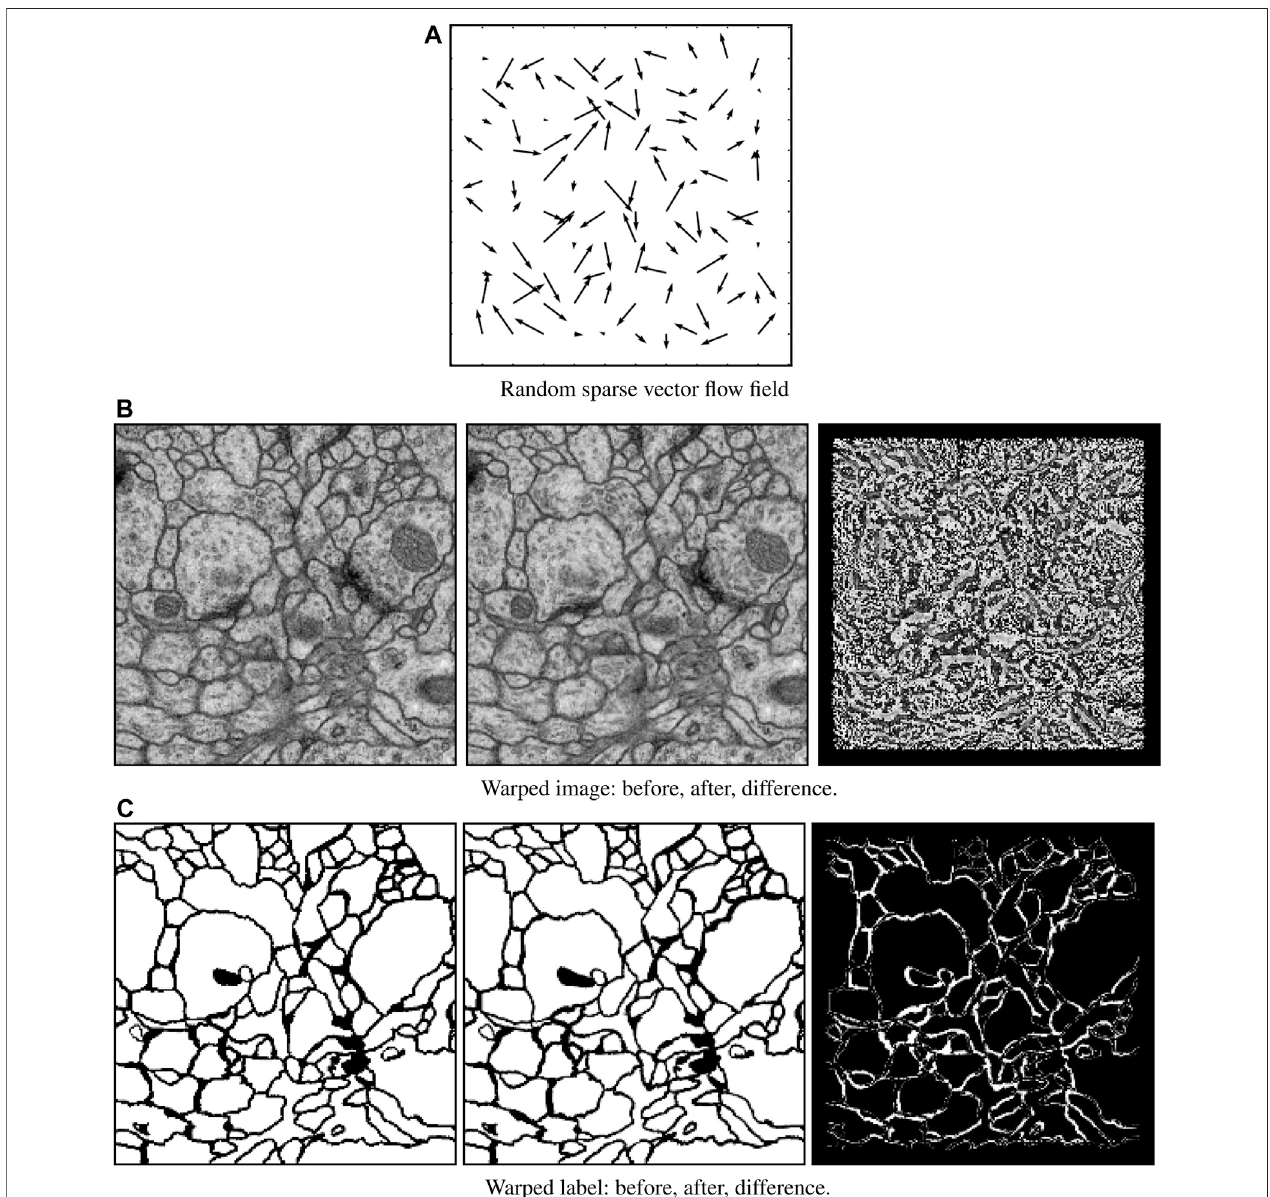
FIGURE 5| Elastic fi eld deformation example. A randomly sparse vector fi eld (A) isgenerated for each training image and labelpair. This sparse vector fi eld isthen used to warp both the original image data ( B , left) and its corresponding label ( C , left) to form an augmentation pair consisting of warped image data ( B , middle) and warped label ( C , middle). The difference between the original and warped images ( B , right) and labels ( C , right) show the effect of deformation.